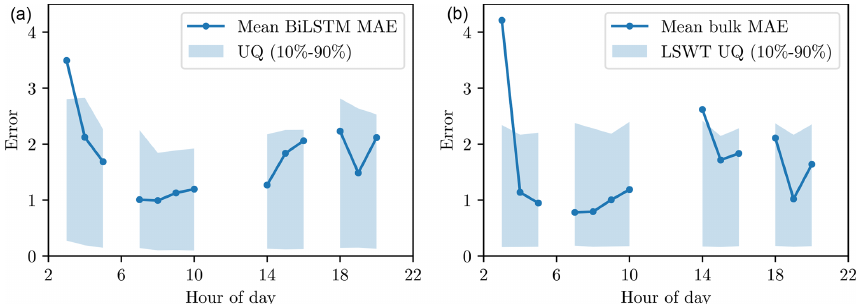
Figure 13. (a) Mean BiLSTM prediction error (dark blue line) and the 10th–90th percentiles of the uncertainties predicted by BiLSTM (shaded areas) for the different hours of the day. (b) Mean bulk temperature prediction error (dark blue line) and the 10%–90% uncertainty estimates based on Lieberherr and Wunderle (2018).